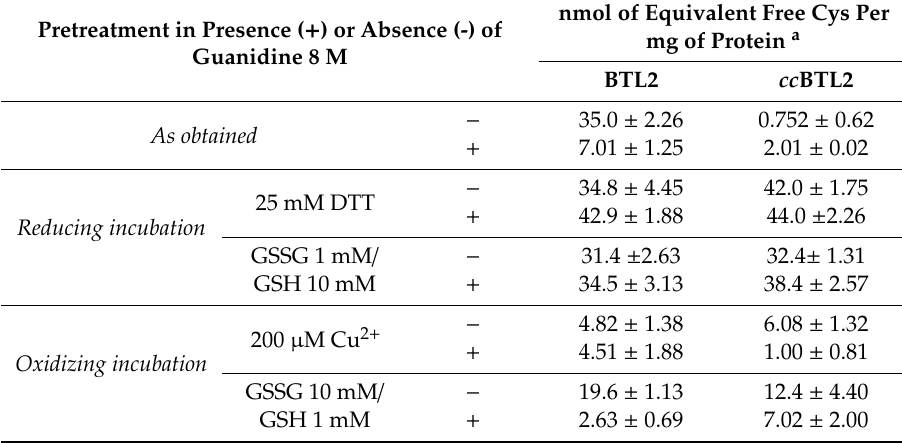
Table 2. 4,4 (cid:48) -dipyridyldisulfide (4-PDS) assay for CNBr-Sepharose ® derivatives (6600 IU of p-nitrophenylbutyrate (p-NPB) / g) after 24 h of di ff erent pretreatments. nmol of Equivalent Free Cys Per Pretreatment in Presence ( + ) or Absence (-) of mg of Protein a Guanidine 8 M BTL2 cc BTL2 − 35.0 ± 2.26 0.752 ± 0.62 As obtained + 7.01 ± 1.25 2.01 ± 0.02 − 34.8 ± 4.45 42.0 ± 1.75 25 mM DTT + 42.9 ± 1.88 44.0 ± 2.26 Reducing incubation GSSG 1 mM / − 31.4 ± 2.63 32.4 ± 1.31 GSH 10 mM + 34.5 ± 3.13 38.4 ± 2.57 − 4.82 ± 1.38 6.08 ± 1.32 200 µ M Cu 2 + + 4.51 ± 1.88 1.00 ± 0.81 Oxidizing incubation GSSG 10 mM / − 19.6 ± 1.13 12.4 ± 4.40 GSH 1 mM + 2.63 ± 0.69 7.02 ±